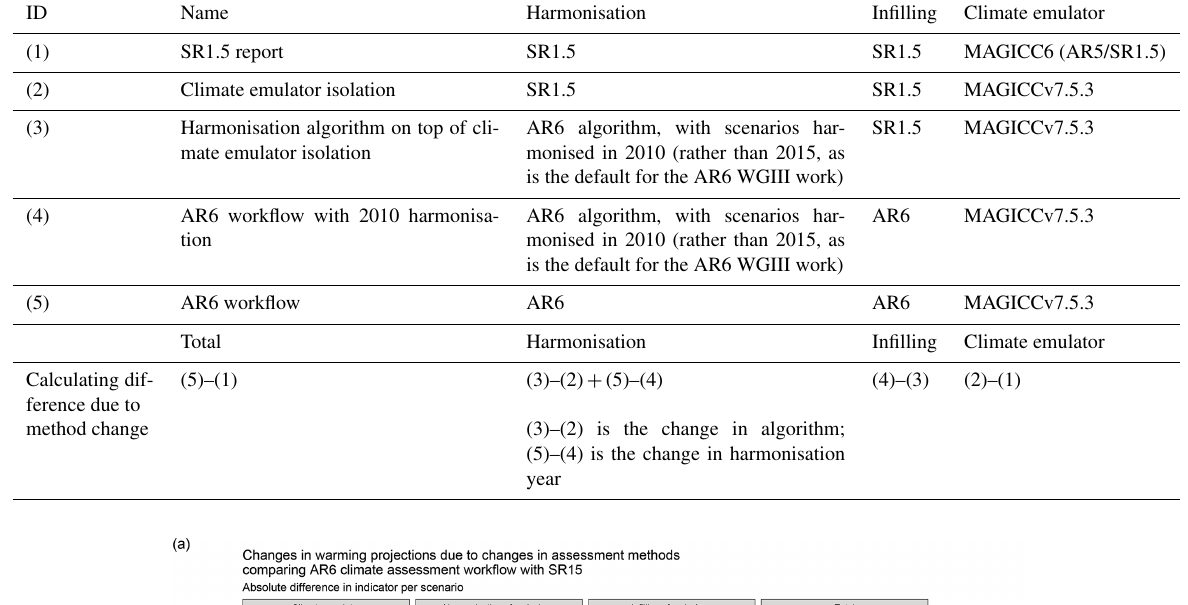
Table 4. Summary of five climate-assessment runs done to isolate the approximate changes in the temperature outcome attributable to each step of the climate-assessment workflow.